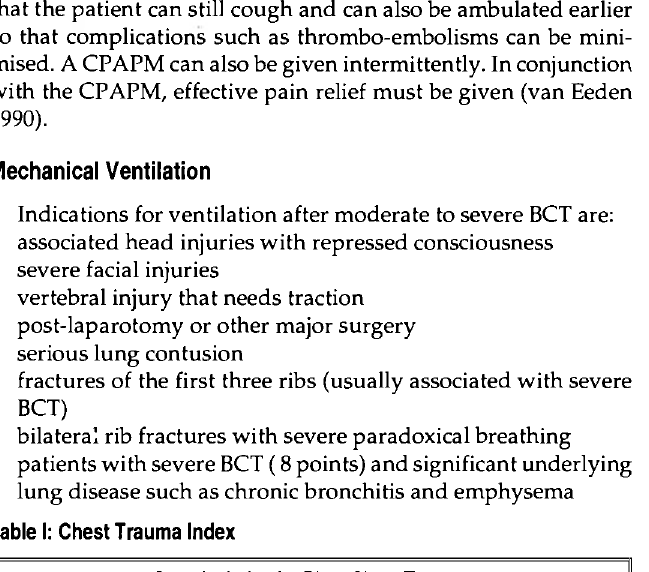
Severity Index for Blunt Chest Trauma Chest Injury